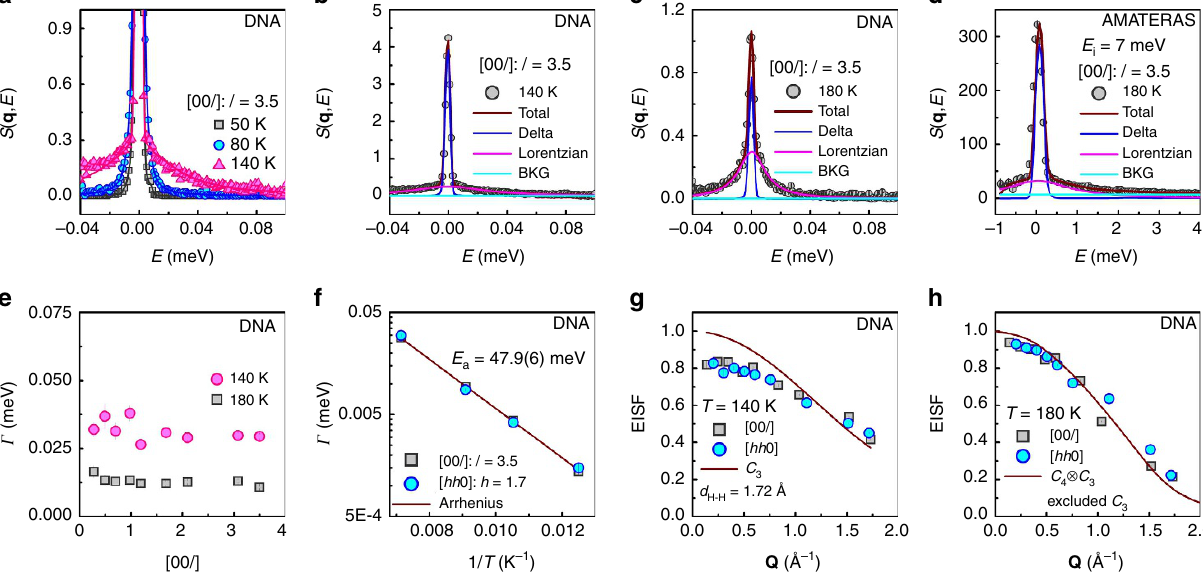
Figure 2 | Jumping rotational dynamics of molecules in CH 3 NH 3 PbI 3 . ( a ) S ( q , E ) at l ¼ 3.5 along [00 l ] at 50, 80 and 140K obtained at DNA. ( b ) The spectral fitting of S ( q , E ) at 140 K for l ¼ 3.5 along [00 l ] direction, by including a delta function, a Lorentzian function and a constant background (BKG). ( c , d ) The spectral fitting of S ( q , E ) obtained at DNA and at AMATERAS at l ¼ 3.5 along [00 l ] direction at 180K, respectively. ( e ) The half width at half maximum ( G ) of the Lorentzian components derived in the fitting, as a function of momentum transfer at 140 and 180K. ( f ) The temperature dependence of G for the orthorhombic phase, fitted to Arrhenius relation G / exp ð(cid:2) E a Þ , where E a is the activation energy of the jumping rotational mode and k B is k B T Boltzmann constant. ( g , h ) the EISF at 140 and 180K compared with C 3 model and C 4 N C 3 model, respectively. In the latter, the C 3 component is excluded. To compare two directions, the real momentum transfer Q is